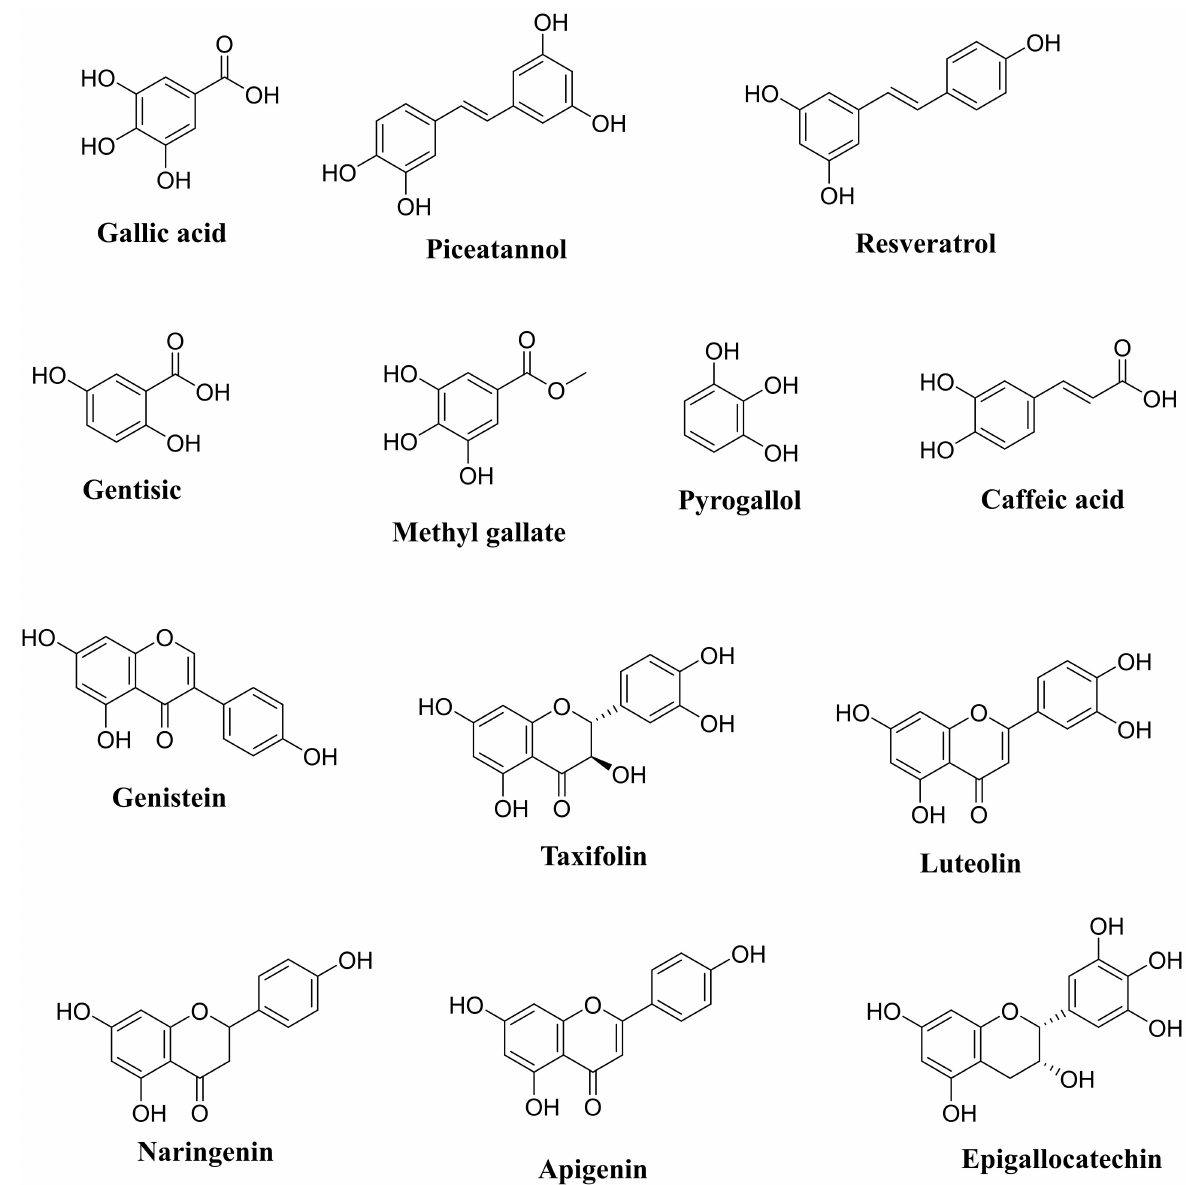
Figure 2. Structures of some important dietary polyphenols. The effect of phenolics from specialty potato cultivars (CO112F2-2, PATX99P32-2, ATTX98462-3, and ATTX98491-3), along with organic, phenolic acid, and anthocyanin fraction (AF), was investigated on androgen-dependent and independent (LNCaP and PC-3) prostate cancer cells. Extracts and AF from the CO112F2-2 cultivar proved to be the most effective in inhibiting cell proliferation and enhancing the cyclin-dependent kinase inhibition-p27, in both LNCaP and PC-3 cells, at 5 µ g chlorogenic acid eq mL − 1 . The induc- tion of apoptosis in both cell types was cell context-dependent. The cell death pathways were most likely associated with c-jun N-terminal kinase and mitogen-activated protein kinase stimulation, which ultimately induced caspase-independent apoptosis, through nuclear translocation of endonuclease G (Endo G) and apoptosis-inducing factor [59]. A recombined standard mixture (RSM) of intrinsically present phenolics from Vaccinium myrtillus berry extract (VME) was tested against hormone-dependent (LNCaP) and hormone-independent (PC3 and DU-145) prostate cancer (PCa) cell lines, in order to assess its action on growth inhibition and pro-apoptotic activity. Normal prostate